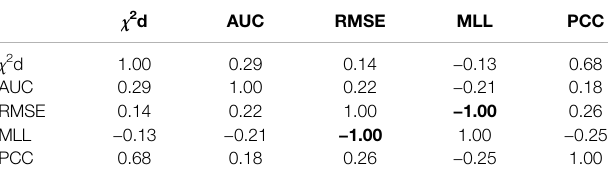
TABLE 3 | Correlation of the popular metrics ’ results.